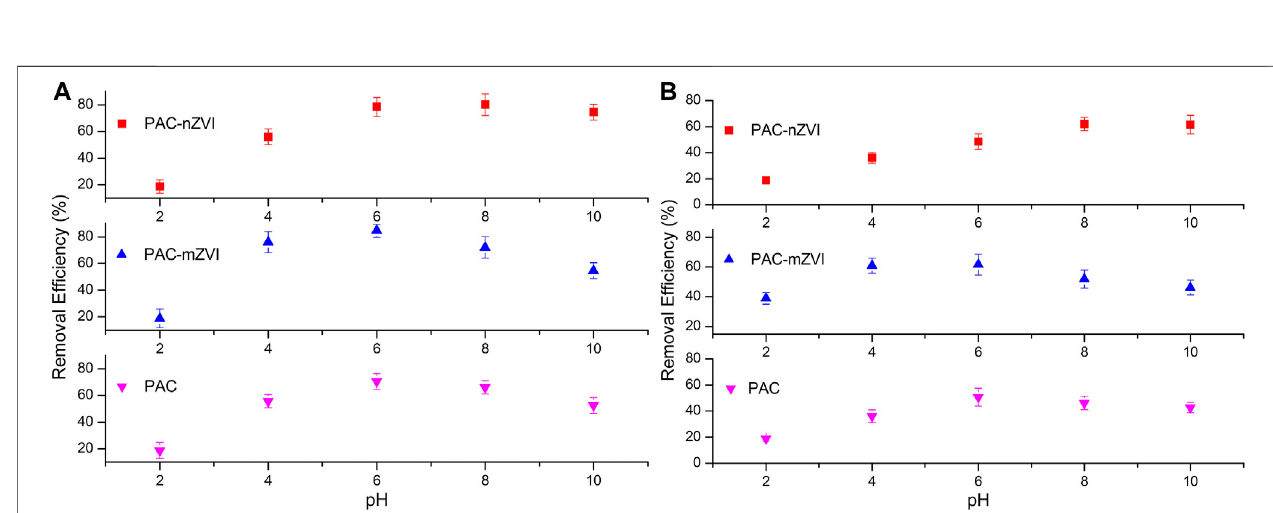
FIGURE 4 | Effects of pH on the removal of CV (A) and MB (B) by PAC, PAC-mZVI, and PAC-nZVI adsorbents.